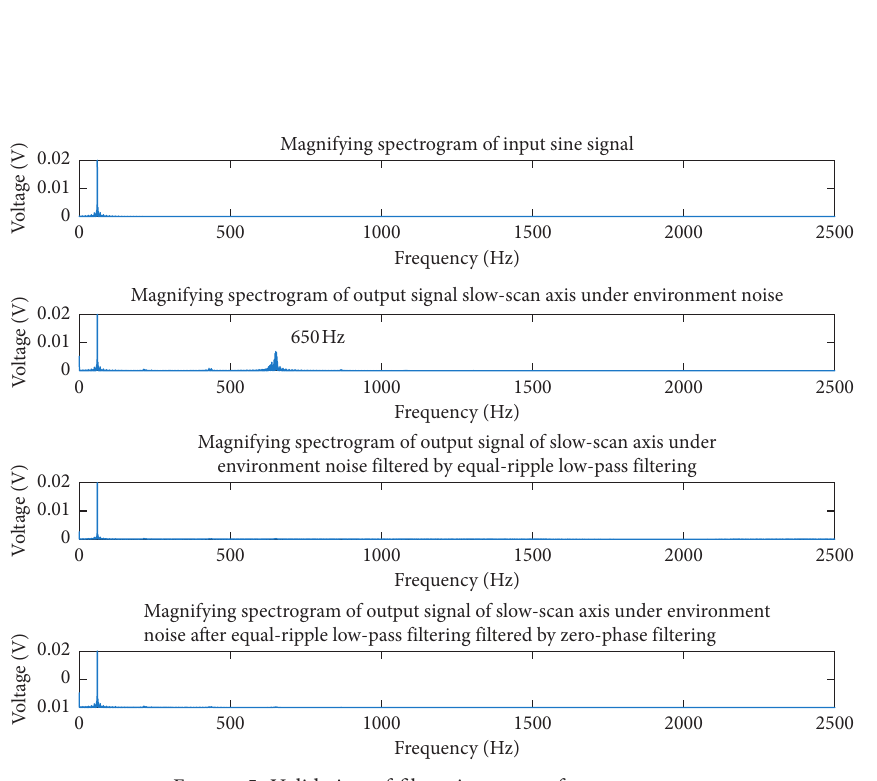
Figure 5: Validation of filters in aspect of spectrogram.